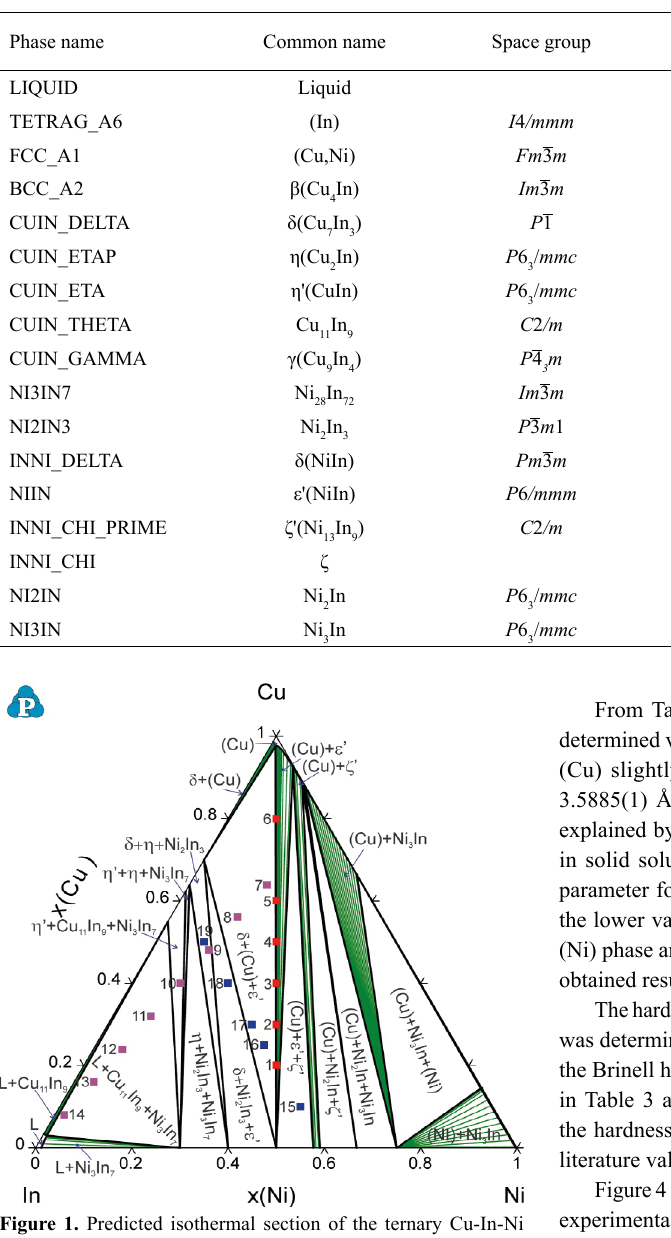
In intermetallic 3 7